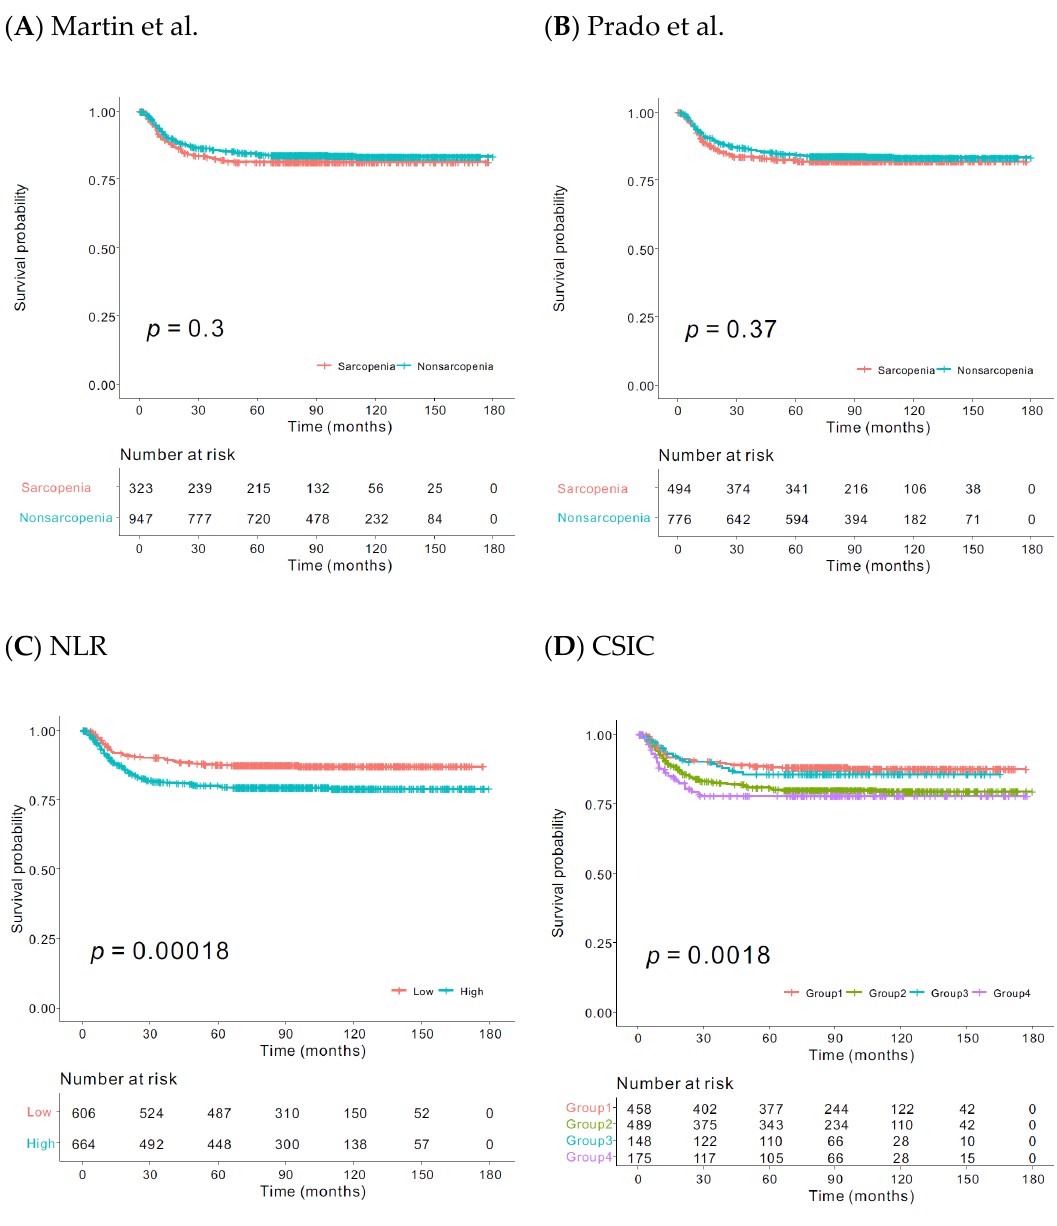
Figure 1. Kaplan–Meier curves of progression-free survival (PFS) in the groups, based on sarcopenia according to ( A ) the criteria by Martin et al., ( B ) criteria by Prado et al., ( C ) neutrophil-to-lymphocyte ratio (NLR), and ( D ) combined sarcopenia and inflammation classification (CSIC).